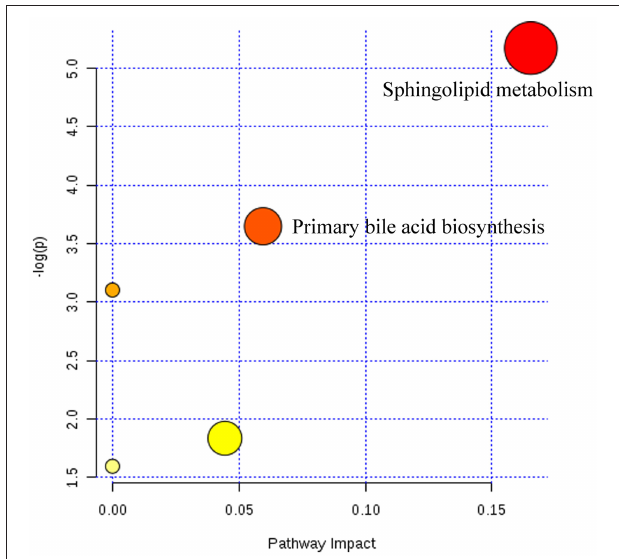
FIGURE 9 | Summary of pathways analysis of healthy rats with PBR administration with MetaboAnalyst. Each point represents one metabolic pathway; the size of dot and shades of color are positively correlated with the impact of the metabolic